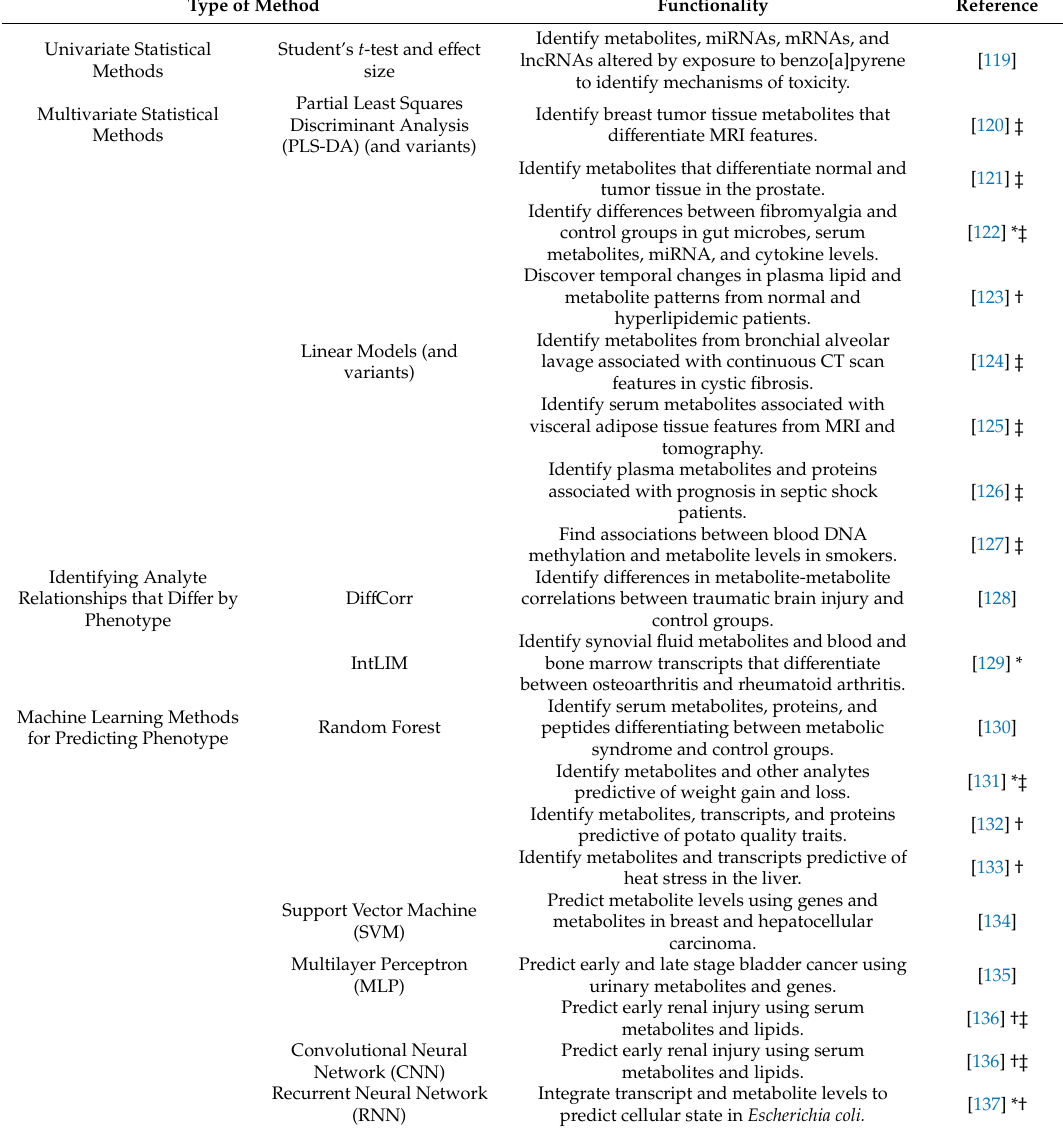
Table 3. Examples of multi-omics applications that identify analytes associated with